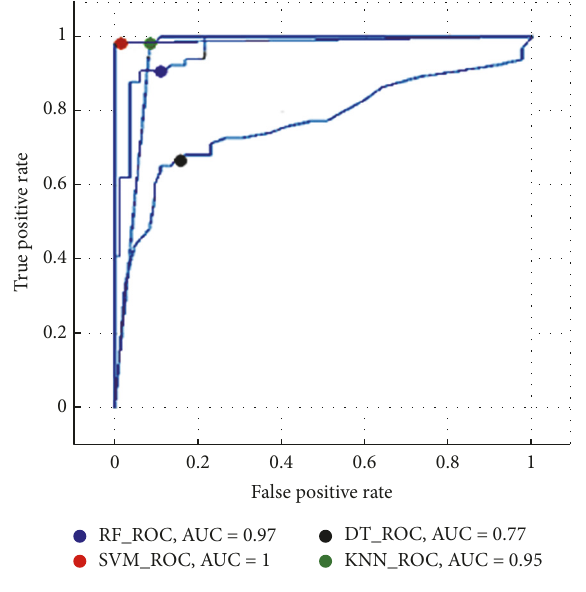
Figure 4: ROC comparison (fuel system). Table 3: Exhaust system VMMS.